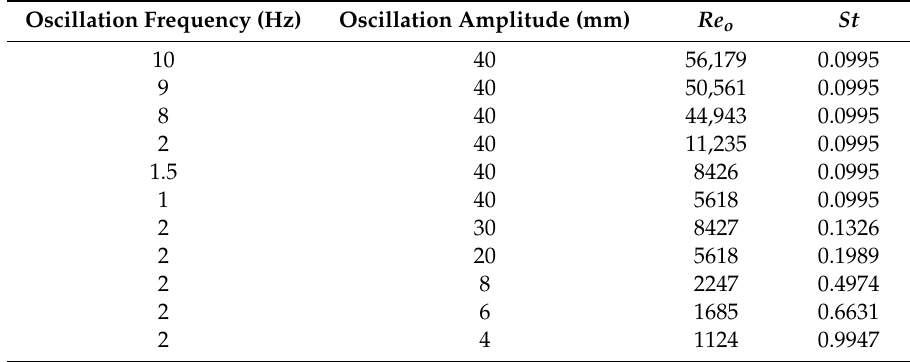
Table 1. Operating conditions used in the